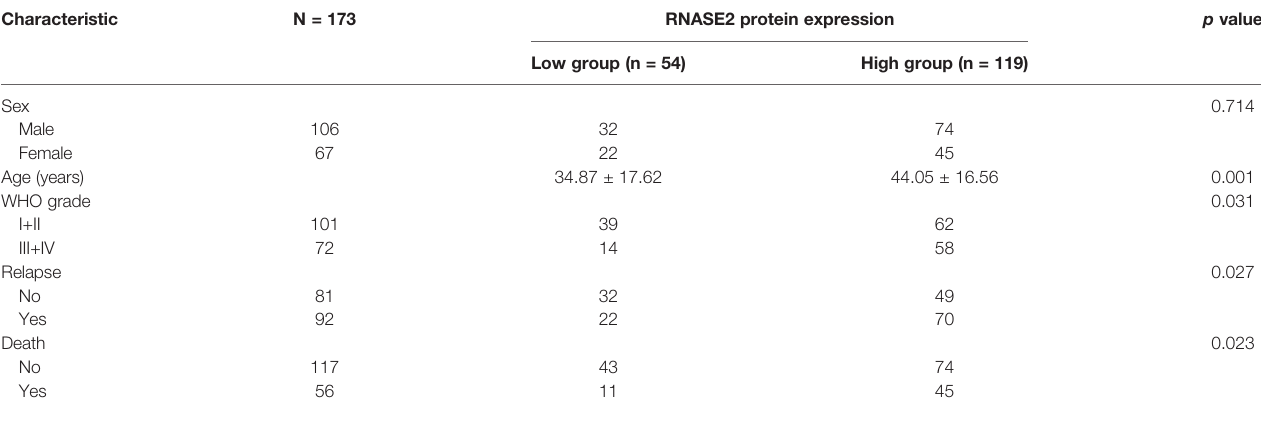
TABLE 2 | Correlation between RNASE2 levels and clinicopathological features of patients with glioma. Characteristic N =